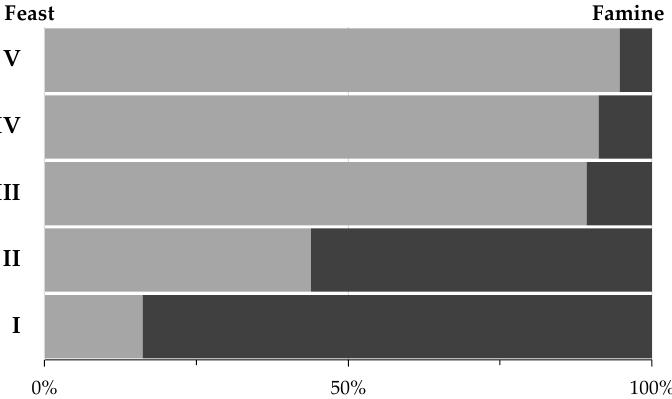
Figure 6. Average fractions of ammonia–nitrogen (N–NH 3 ) consumption in the feast (light grey) and famine (dark grey) phases of the selected SBR, during the five different operational periods (I–V). The consumption percentages are based on the total consumed ammonia–nitrogen, during the entire cycle.